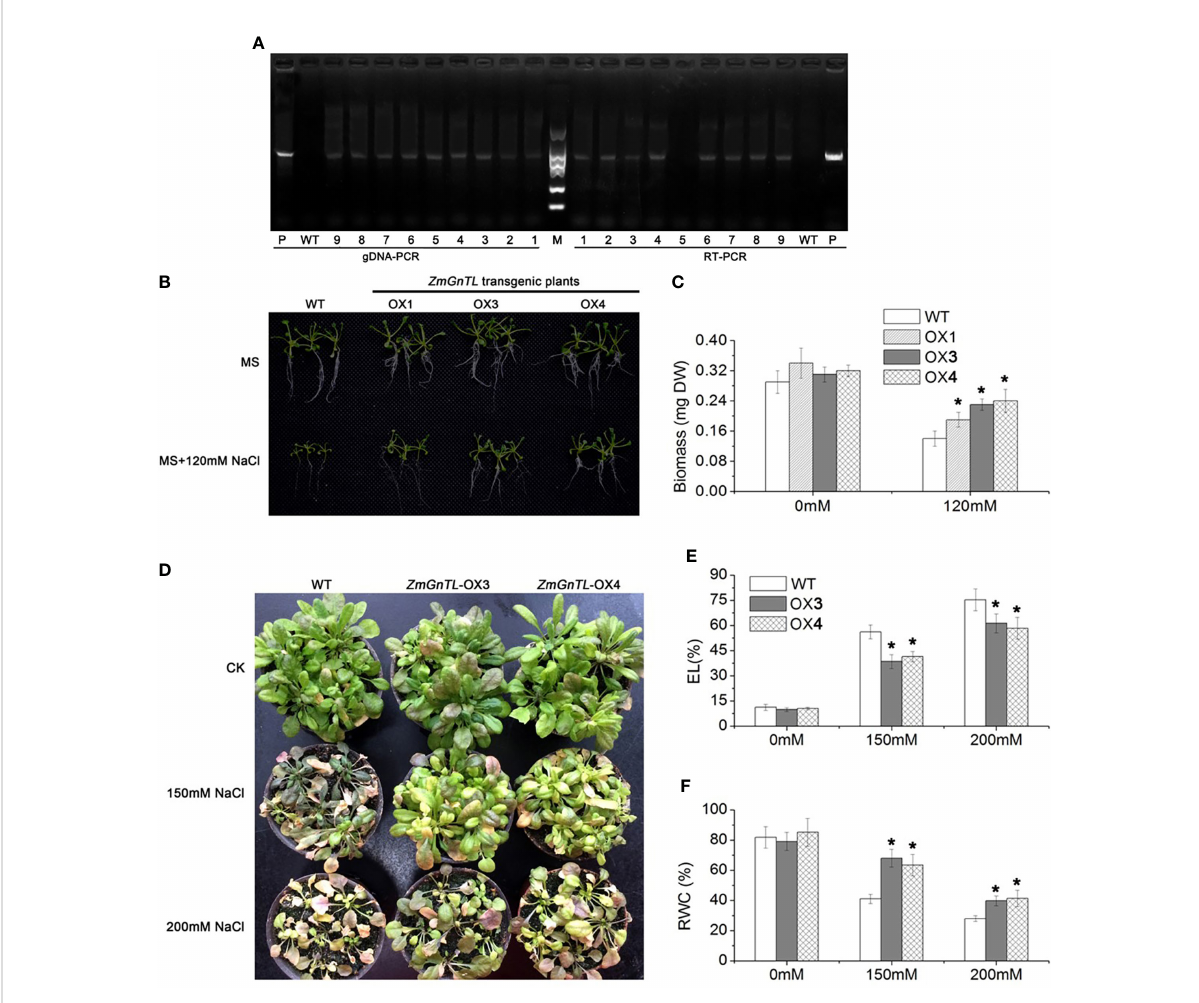
FIGURE 5 Overexpression of ZmGnTL enhanced the salt-tolerance in Arabidopsis . (A) gDNA -PCR and RT-PCR analysis of transgenetic lines, P ( ZmGnTL plasmid), WT (wild type), 1-9 (transgenetic lines). (B) A comparison of salt-tolerant phenotypes and wildtype (WT) grown on MS medium. (C) Biomass of Arabidopsis seedlings grown on MS medium. (D) A comparison of salt-tolerant phenotypes and WT in soil matrix. (E, F) Electrolytic leakage (EL) and relative water content (RWC) of Arabidopsis plants. Data are shown as means ± SE of three to fi ve biological replicates, and * indicated statistical signi fi cance at P<